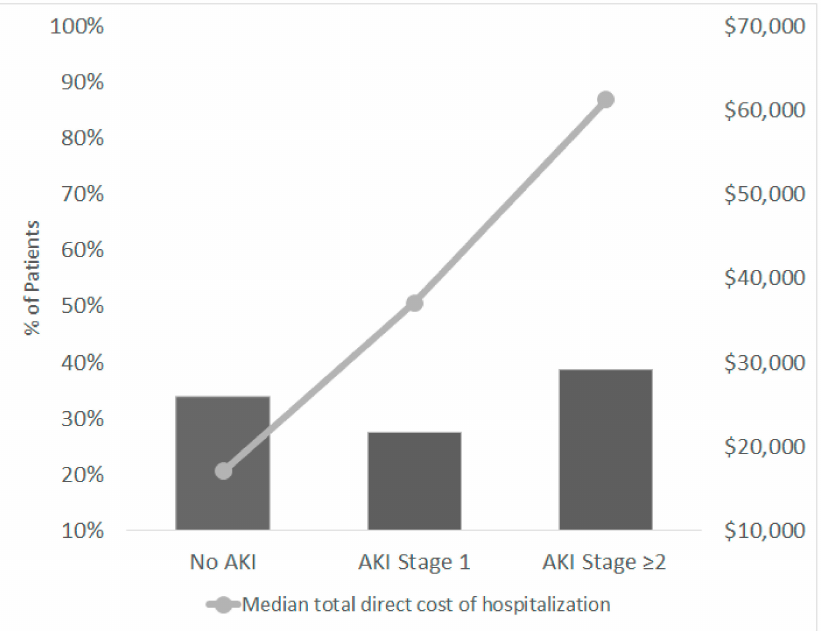
Figure 2. Incidence of acute kidney injury and median total hospitalization direct cost in hospitalized patients with a primary diagnosis of infective